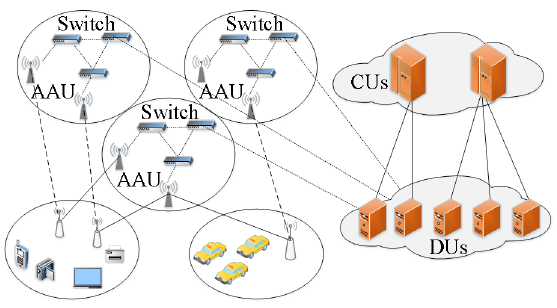
Figure 1. Fronthaul network structure with CUs, DUs, and AAUs.